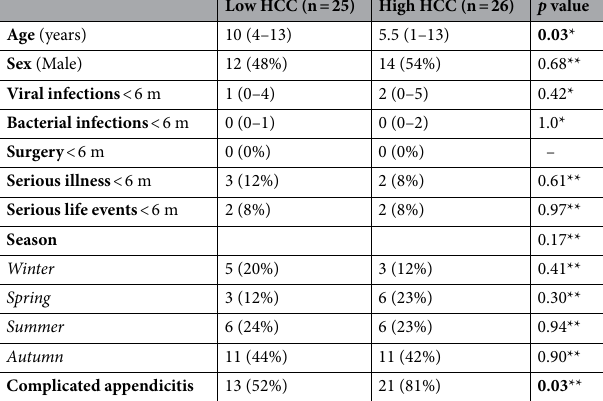
Table 2. Level of hair cortisol concentration in 51 patients with appendicitis. Values presented as median (min–max) or as absolute number (percentage of patients/controls); HCC: hair cortisol concentration; Low HCC: < 21.03 pg/mg (median), high HCC ≥ 21.03 pg/mg (median; *Mann–Whitney U-test, **Chi-squared